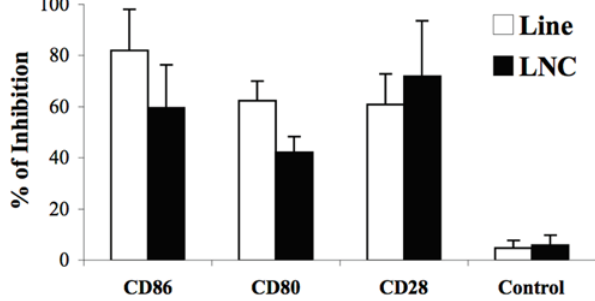
Figure 5. The activation HSP60-specific anti-ergotypic T cells requires co-stimulation. Monoclonal antibodies to CD28, CD80 or CD86, or a control IgG (Control), were assayed for their ability to block the anti-ergotypic proliferative response of Anti-HSP60 T-cells (Line) or of LNC prepared from pHSP60-vaccinated rats (LNC). Results are presented as the percent of inhibition of proliferation 6 SEM of quadruplicate cultures. Three independent experiments produced similar